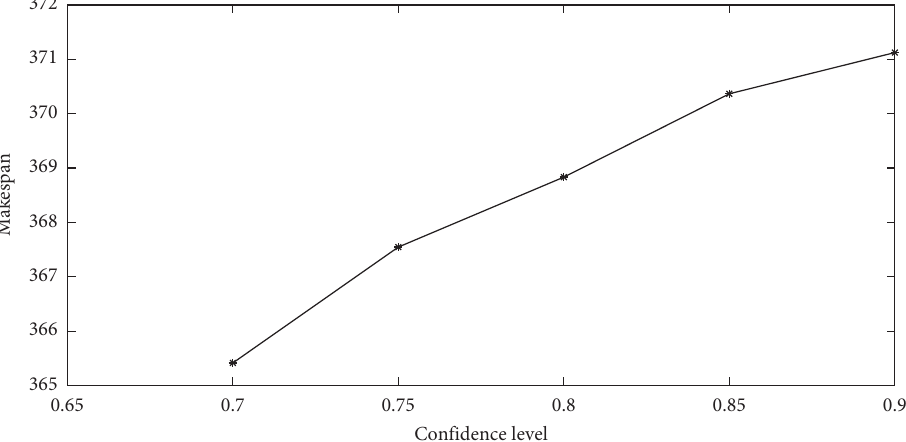
Figure 1: The sensitivity of solution for makespan problem.